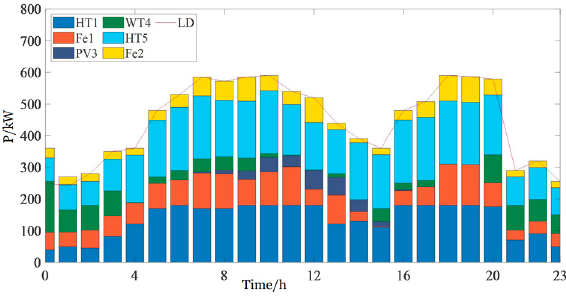
Figure 12. Total power generation and load.